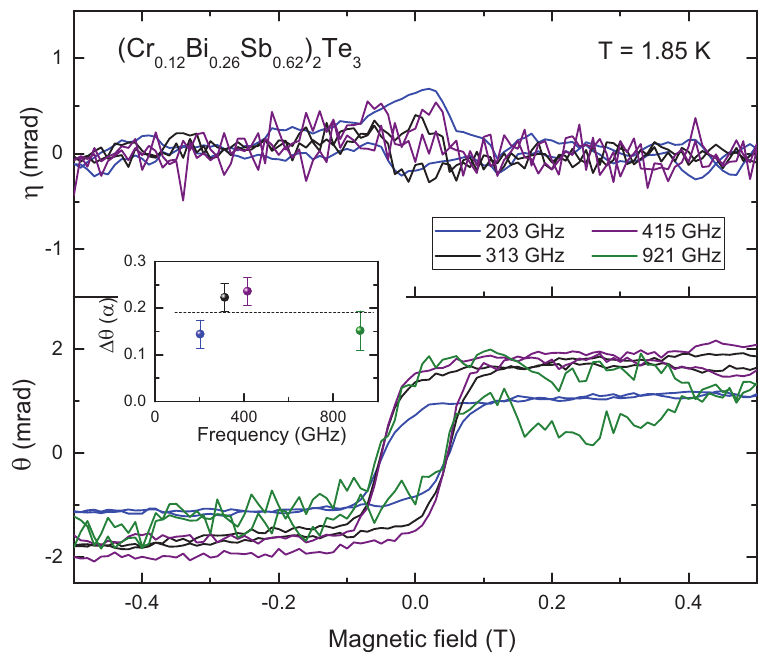
Figure 3. Complex polarization rotation angle θ + i η in (Cr 0.12 Bi 0.26 Sb 0.62 ) 2 Te 3 at T = 1.85K and at different frequencies. The frequencies were selected at the maxima of the Fabry-Pérot interferences to suppress the effect of the substrate in the spectra. Bottom panel: Faraday rotation angle θ , top panel: ellipticity η . The inset shows the absolute values of the rotation angle due to quantum anomalous Hall effect (QAHE) in the units of the fine structure constant at zero magnetic field and as a function of frequency. Straight dashed line is to guide the